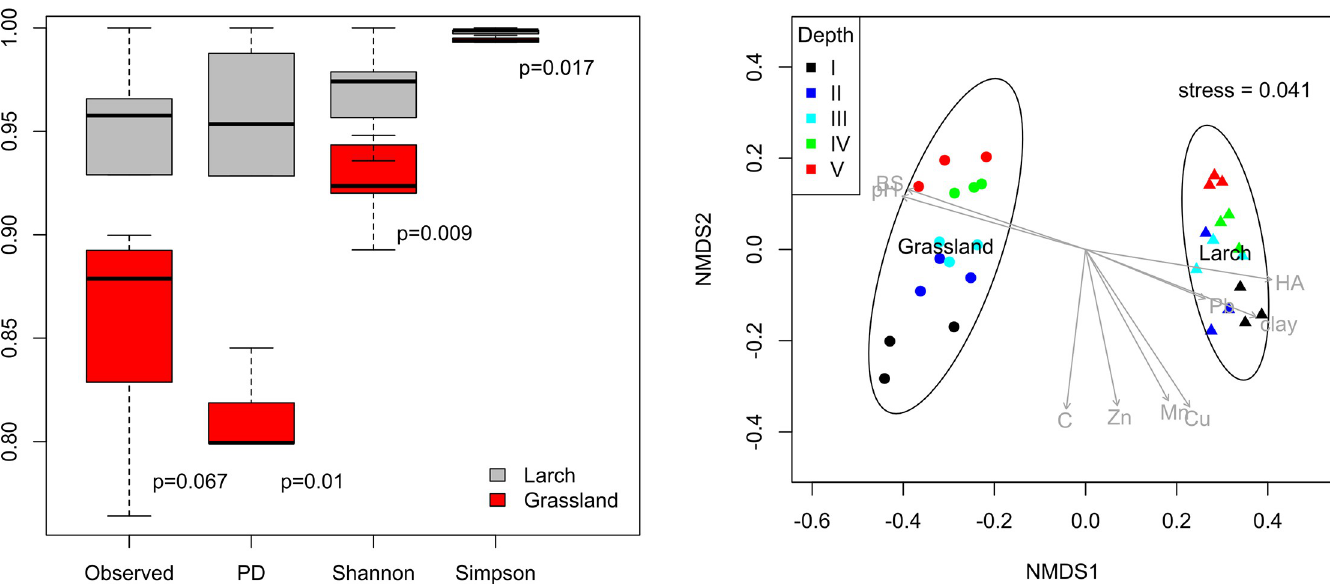
Fig 2. a. Diversity indices of mountain-meadow soil under grassland vegetation (Grassland) and under artificial plantations of larch (Larch). Index values � were normalized to their corresponding maximum values. � Raw values of the alpha diversity indices are given in S2 Table. b. Beta-diversity (based on Bray-Curtis distance matrix) of soil microbiomes under grassland vegetation (Grassland) and under artificial plantations of larch (Larch). Roman numerals correspond to the depth of sampling: I—0–5 cm, II—5–10 cm, III—10–15 cm, IV—15–20 cm, V—20–25 cm. For stress plot of MNDS-analysis please refer to S3 Fig.